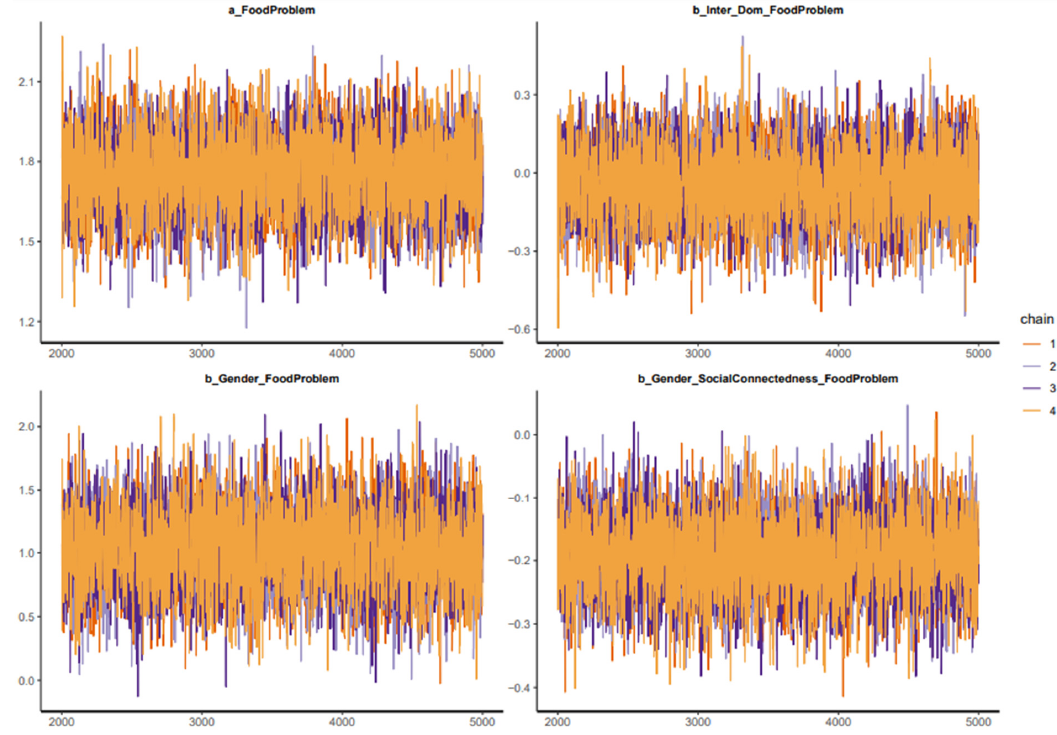
Figure 3. Trace plots for the model’s posterior coefficients. As shown in Figure 4, the shrink factors rapidly drop to one during the warm-up phase, meaning that the average variance between chains and the average variance within chains are similar, which indicates good convergence [51]. Additionally, we can observe in Figure 5 that the autocorrelation for each parameter is quickly eliminated, which again confirms the healthy Markov property of the chains.